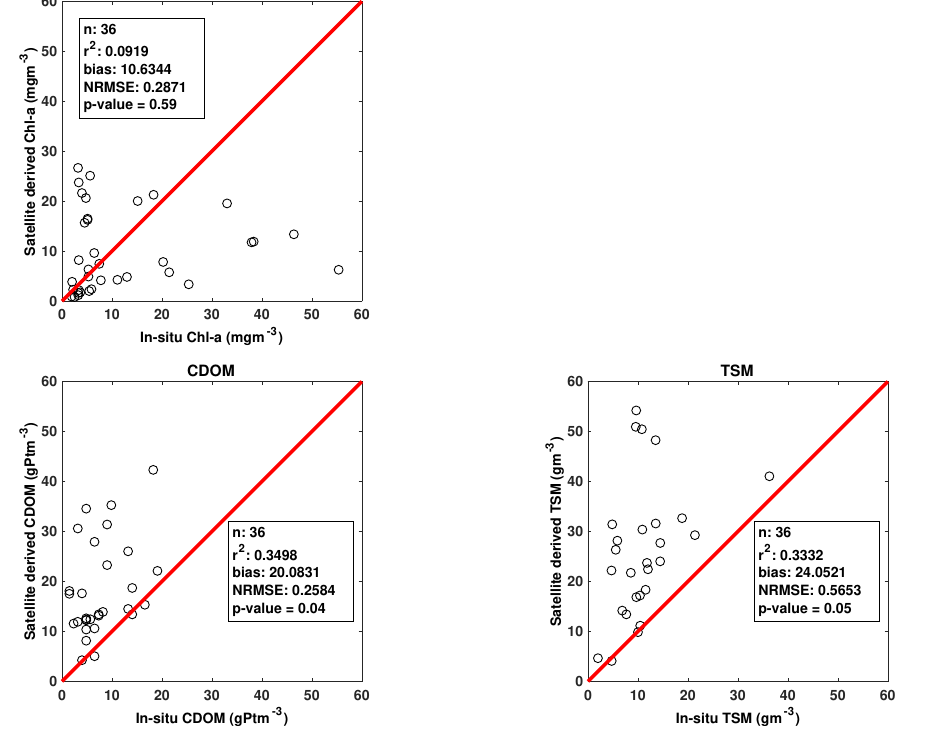
Figure 5. In situ versus satellite-derived water quality concentrations: Chl-a ( top ), CDOM ( bottom-left ) and TSM ( bottom-right